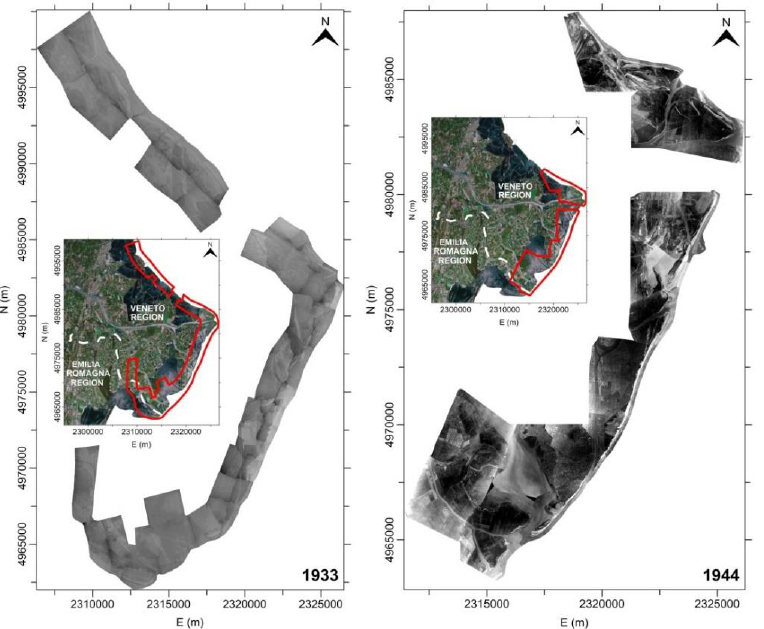
Figure 4. Photo-plan mosaic of the 1933 and 1944 aerial photogrammetric surveys: coverage is restricted to the coastal area; some photographs on glass plates ( 1933 ) and on film ( 1944 ) were lost, producing lack of data in the planimetric representation; available aerial images are characterized by poor visibility.